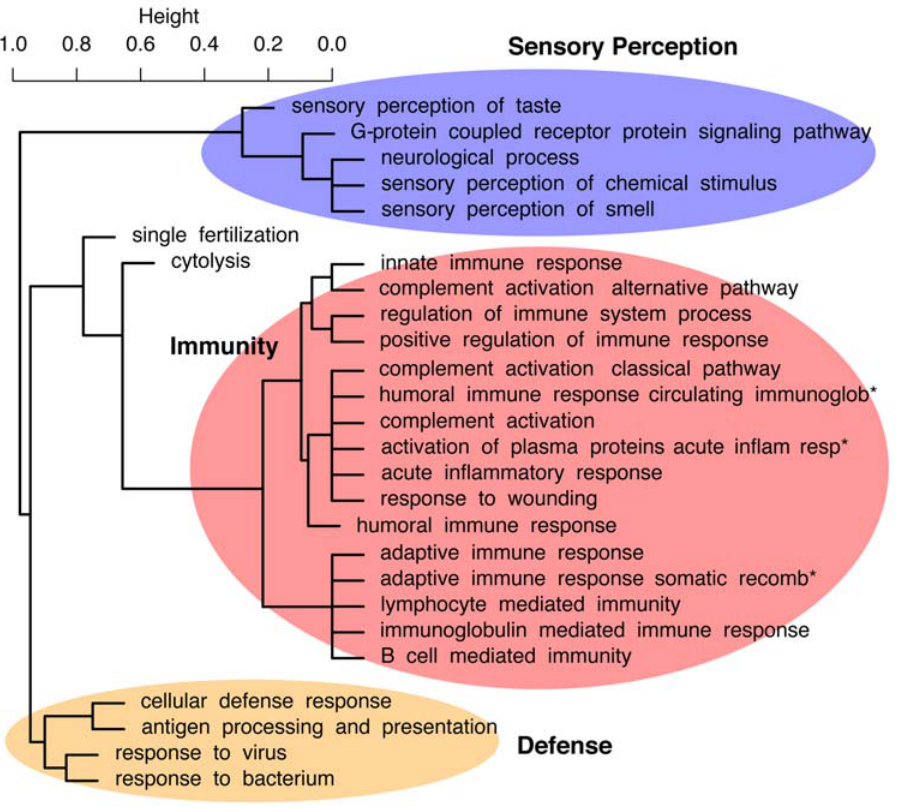
Figure 2. Hierarchical clustering of 27 over-represented GO categories identified by the Mann-Whitney U test (‘‘biological process’’ group only), based on the genes assigned to each category. This dendrogram is derived from a dissimilarity matrix defined such that any two GO categories, X and Y , have dissimilarity 0 when all genes assigned to X are also assigned to Y (or vice-versa), and dissimilarity 1 when the sets of genes assigned to X and Y do not overlap. Specifically, X and Y have dissimilarity d XY ~ 1 { N X ð Þ \ N Y ð Þj j = min N X ð Þj j , N Y ð Þj jf g , where N C ð Þ denotes the (nonempty) set of genes assigned to GO category C . Thus, GO categories associated with similar sets of genes group together in the dendrogram, even if these categories are not closely related in the GO hierarchy (such as ‘‘cytolysis’’ and ‘‘single fertilization’’). Full names of abbreviated categories (*) are ‘‘humoral immune response mediated by circulating immunoglobulin,’’ ‘‘activation of plasma proteins during acute inflammatory response,’’ and ‘‘adaptive immune response based on somatic recombination of immune receptors built from immunoglobulin superfamily domains.’’ (Dendrogram produced by the hclust function in R with method=‘‘average’’ .)